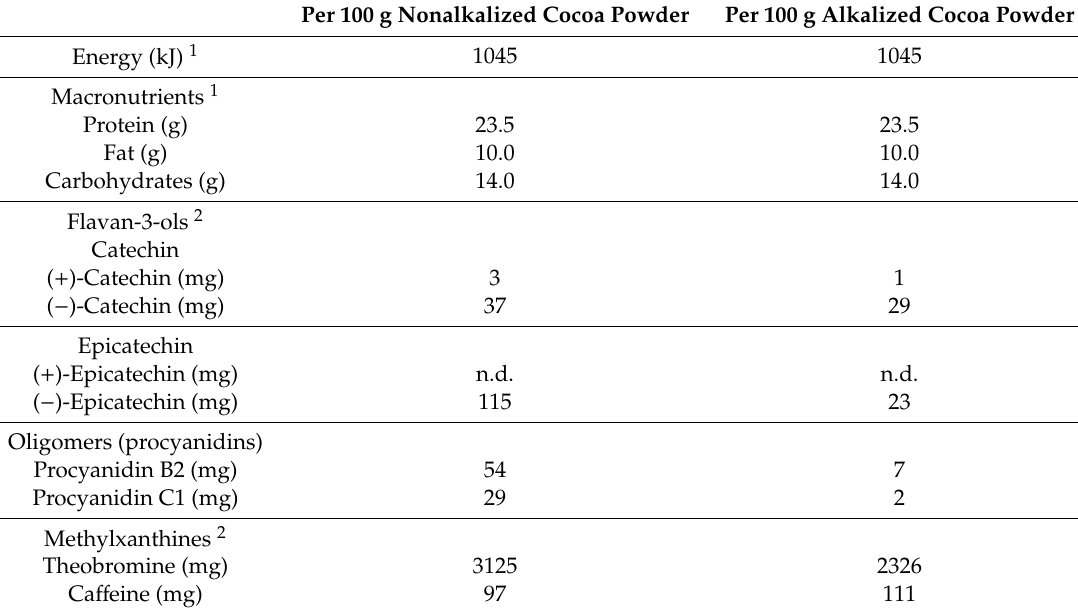
Table 1. Composition of the cocoa powders.